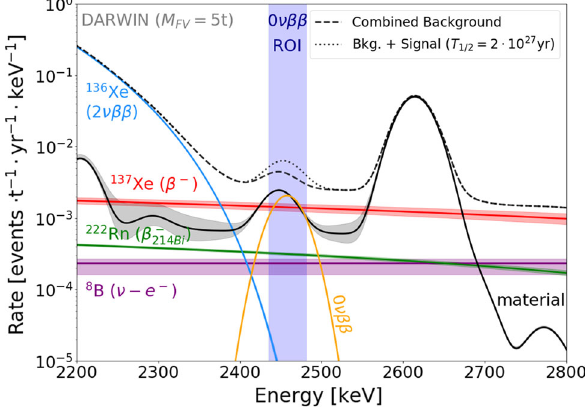
Fig. 7 Predicted background spectrum around the 0 νββ -ROI for the 5t fiducial volume. A hypothetical signal of 0.5 counts per year cor- ≈ 2 × 10 27 years is shown for comparison. Bands responding to T 0 ν 1 / 2 indicate ± 1 σ